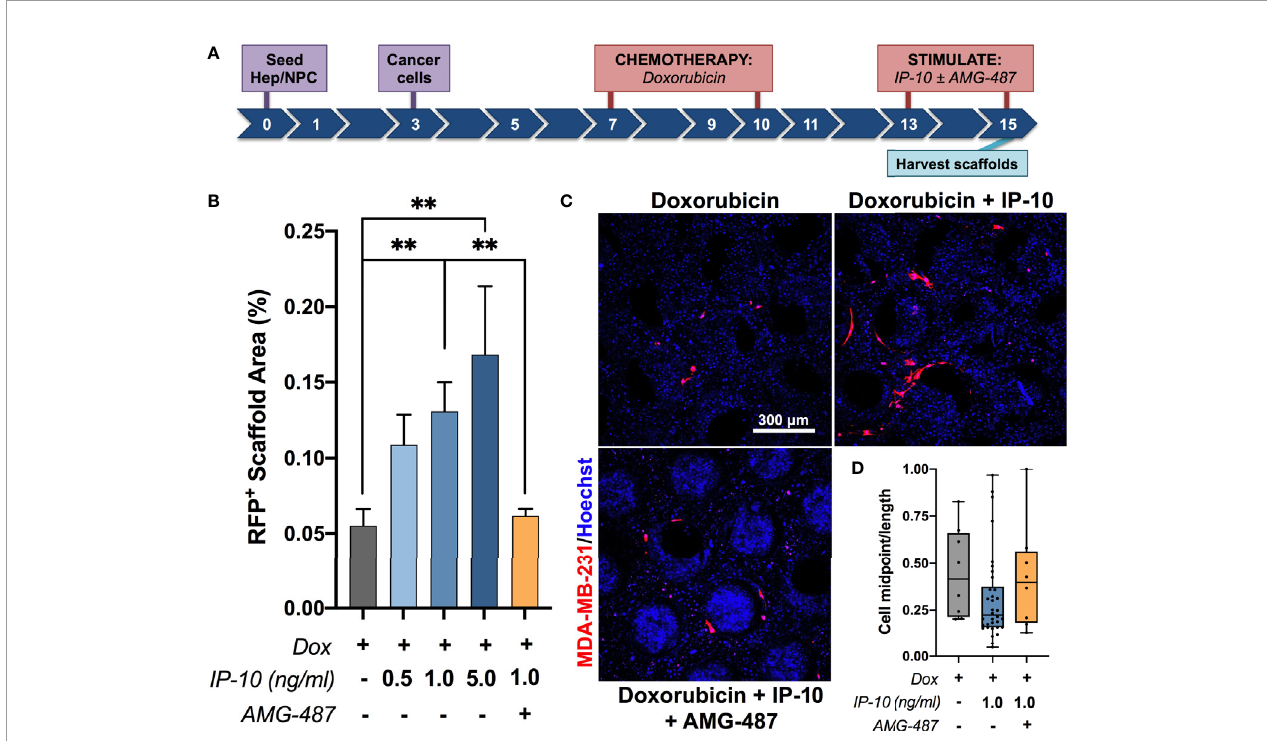
FIGURE 2 | IP-10 promotes the emergence of dormant breast cancer cells in an ex vivo hepatic niche. (A) Experimental timeline schematic. (B, C) Quanti fi cation and representative images of the outgrowth of dormant MDA-MB-231 cells following stimulation in the presence or absence of an inhibitor (AMG-487) for 48 hours on day 15 (mean ± SEM; Mann-Whitney test, ** p < 0.01; n = 2-5 donors). Blue – DAPI; Red – MDA-MB-231 RFP + cells. (D) Quanti fi cation of the cell midpoint-to- length ratio of MDA-MB-231 RFP + cells within the representative images depicted in (C) (median with quartiles and